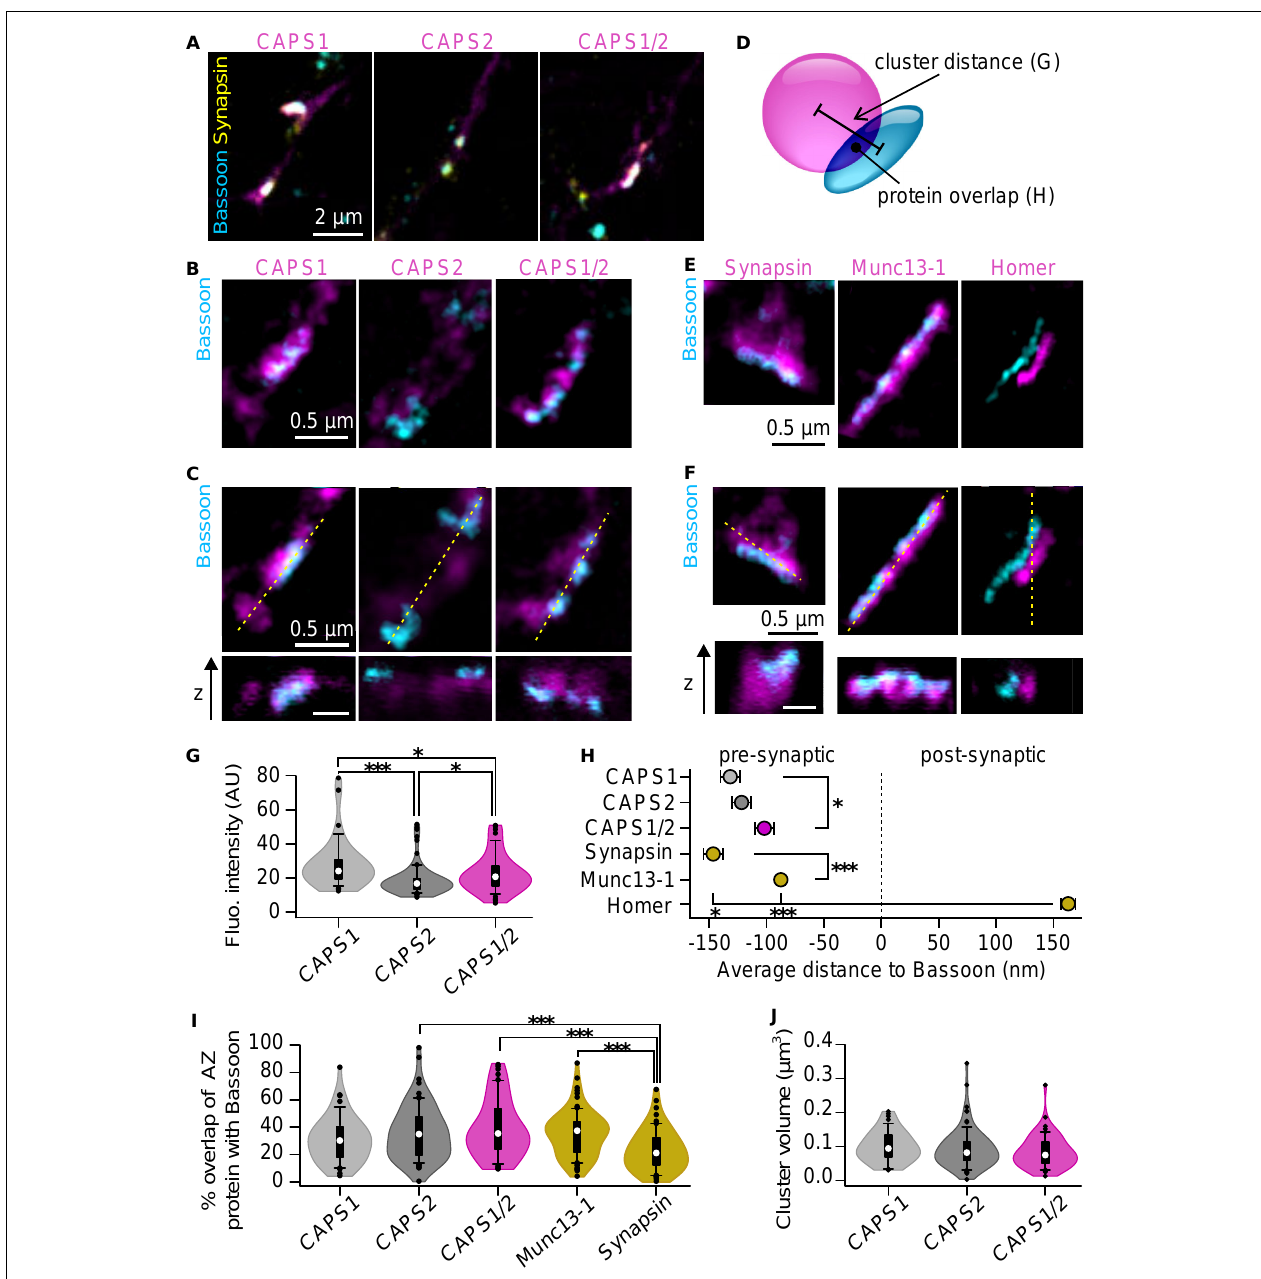
FIGURE 6 | 3D STED microscopy resolves CAPS1 N-terminus function in CAPS1 accumulation near active zones. (A–C) DRG CAPS dKO neurons infected with CAPS1- CAPS2b or CAPS1/2 chimera-HaloTag and co-cultured with WT SC neurons. Vital staining of the cells with HaloTag ligand CA-ATTO590 (magenta) was conducted on DIV6 followed by immunostaining for bassoon (cyan) and synapsin (yellow) on DIV9. (A) Representative confocal overviews of neurite networks for each CAPS construct. Enlarged portion of a synapse outlined in (A) acquired with 2D (B) or 3D (C) STED microscopy. The 3D STED images display a sagittal and an axial section of the synapse. The orientation of the axial section is indicated as a dashed yellow line on the sagittal section. Scale bar is 0.5 µ m for all STED images. (D) Schematic representation of image analysis. 3D protein clusters were defined on the 3D STED images. Their center of mass was used to calculate the distance between CAPS and bassoon clusters. Further, their degree of overlap and volume was quantified. (E,F) DRG/SC WT neuron co-culture immunostained for bassoon and either synapsin, Munc13-1, or Homer. Representative 2D (E) and 3D (F) STED micrographs. Scale bar is 0.5 µ m. (G) Average fluorescence intensities within the defined CAPS clusters. (H) Mean distance between the center of mass of the indicated protein clusters relative to bassoon cluster (* p = 0.038 for CAPS1 CAPS2b and CAPS1/2, * p = 0.048 for synapsin and Homer or *** p < 0.001). (I) Percentage of indicated protein cluster overlapping with bassoon (*** p < 0.001). (J) Analysis of CAPS cluster volume. CAPS1 n = 48 CAPS2b, n = 78, and CAPS1/2 n = 59 synapses ( N experiment = 3); Munc13-1 n = 83; synapsin n = 61 and Homer n = 64 synapses ( N = 1). Statistical significance determined by one-way ANOVA on ranks followed by Dunn’s post hoc test. The violin plots include a box plot with the median shown as a white dot, and outliers as black